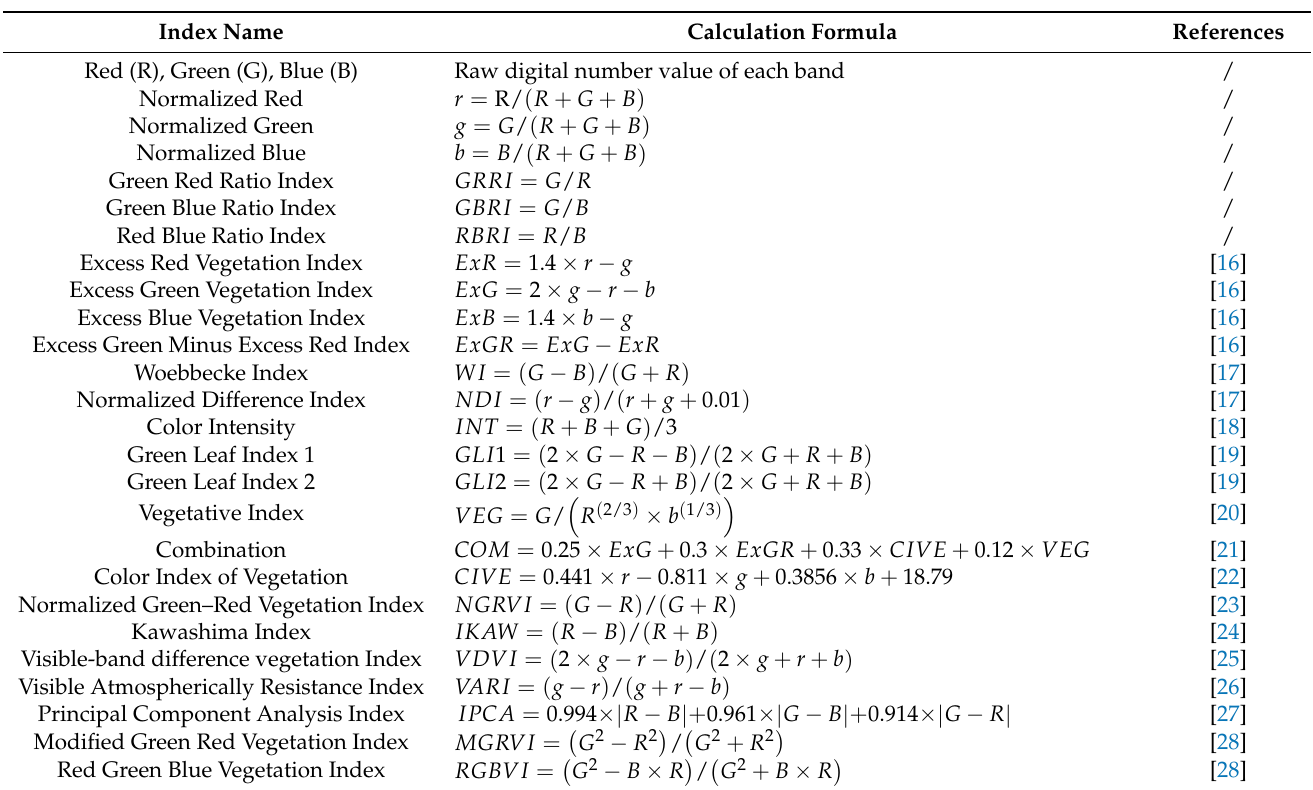
Table 3. Vegetation indices based on RGB digital number value and calculation method.